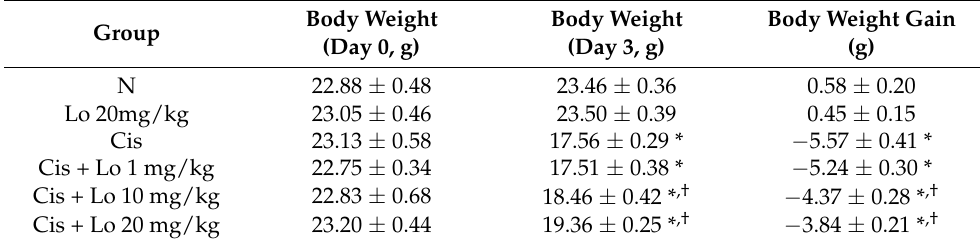
Table 1. Effects of loganin on body weight in cisplatin-induced AKI.